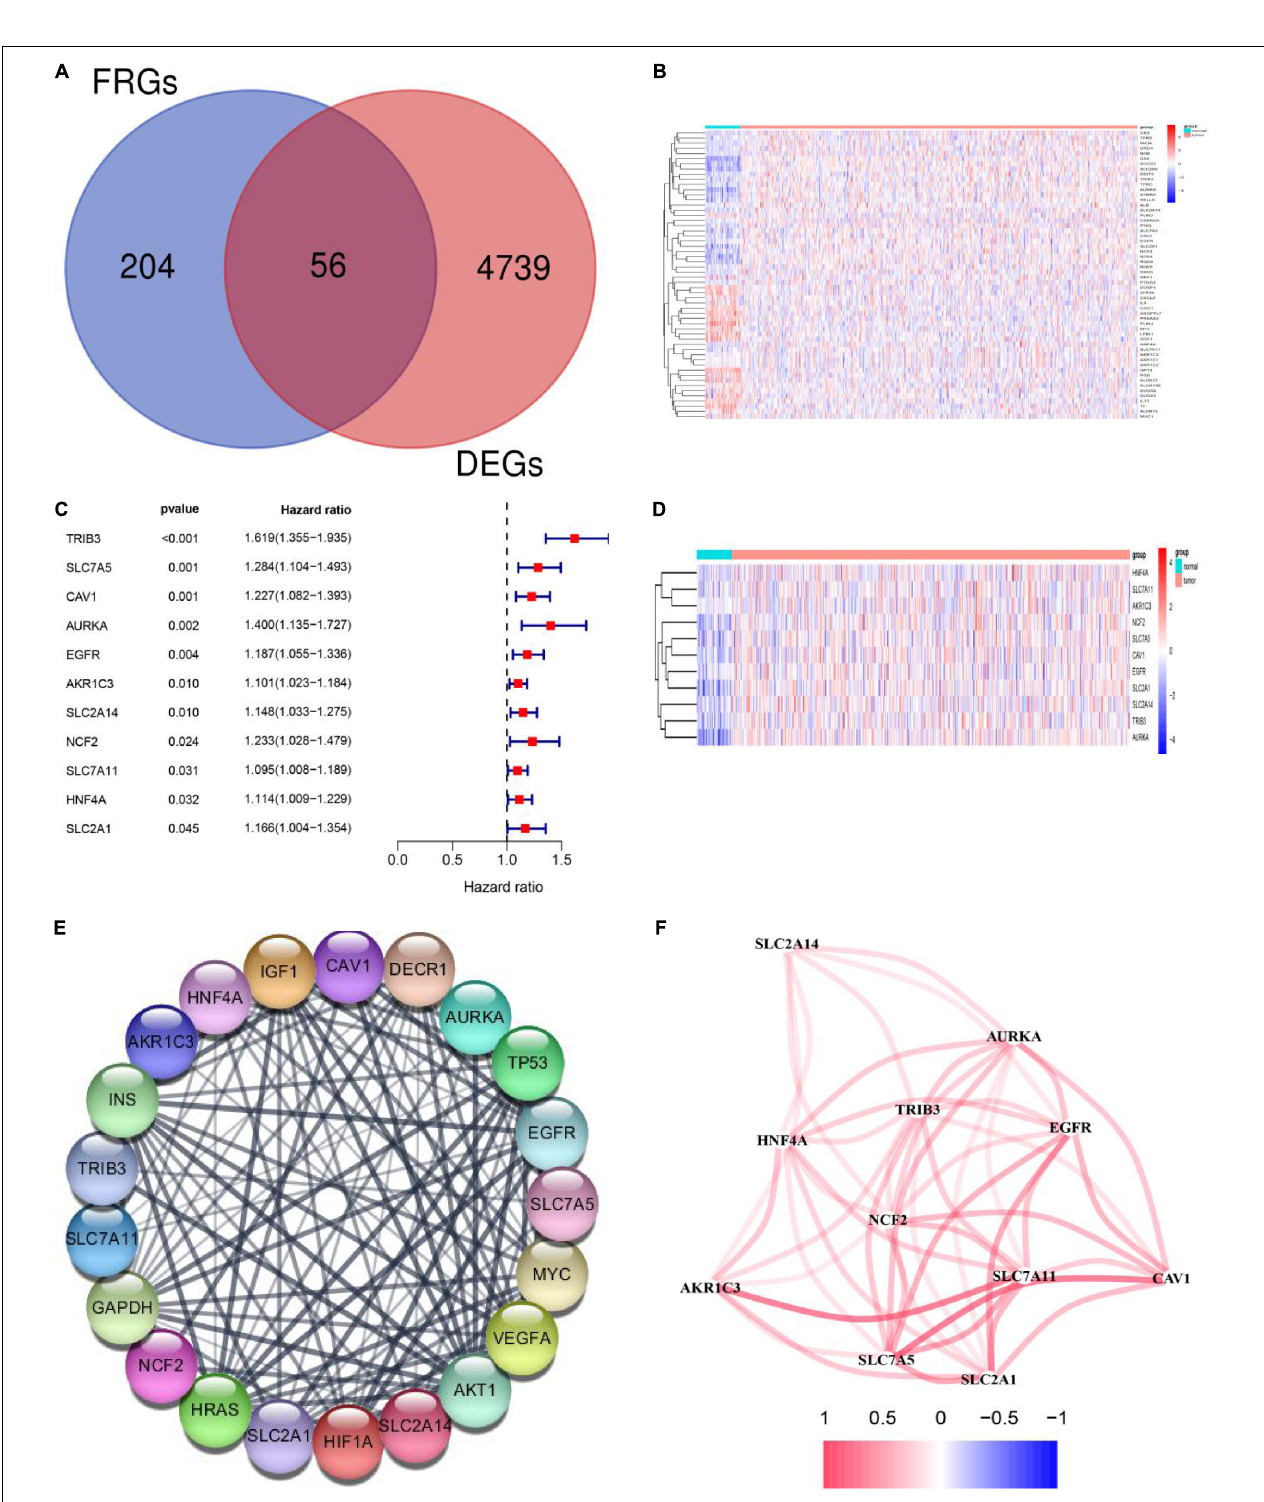
FIGURE 2 | Identification of differentially expressed genes (DEGs) and prognosis-related ferroptosis-related genes (FRGs) in squamous cell carcinoma of the head and neck (HNSCC) using the cancer genome atlas (TCGA) cohort. (A) Venn diagram showing DEGs related to ferroptosis in the TCGA-HNSCC cohort. (B) The 56 overlapping genes are shown in the heatmap. There were 33 genes that were upregulated and 23 genes that were downregulated in tumor tissues compared with the adjacent normal tissues. (C) Univariate Cox regression analysis identified 11 prognosis-related FRGs. (D) All 11 FRGs related to prognosis were upregulated in tumor tissues. (E) The protein -protein interaction (PPI) network shows interactions between the 11 FRGs related to prognosis. (F) The networks related to the 11 FRGs. Different colors represent different correlation coefficients.